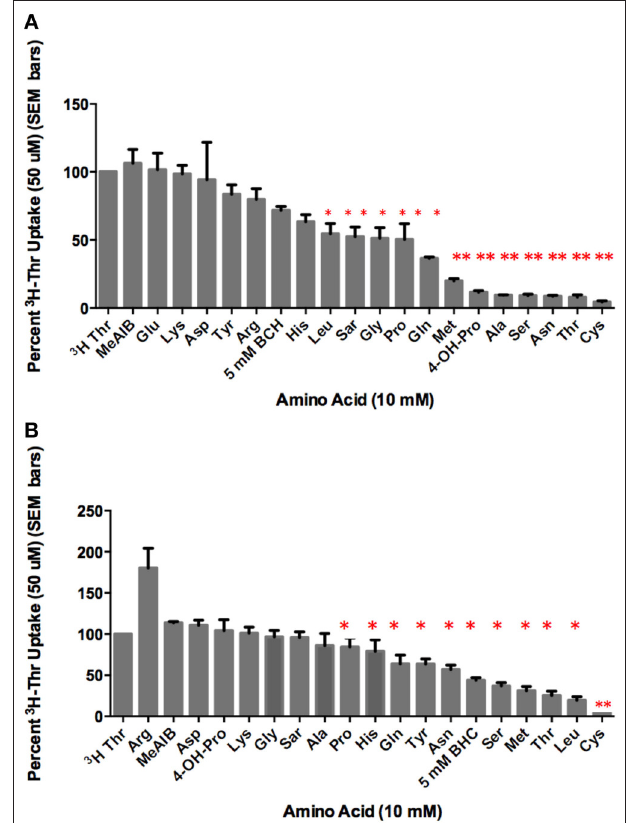
FIGURE 2 | Percent uptake of 50 uM [ 3 H]-Thr in the presence of 140mM NaCl and 10mM of the amino acid indicated. (A) A 1-sample t -test determined the more complete inhibitors (** p < 0.0001 ) and other statistically significant inhibitors ( * p < 0.05 ) ( n = 6 for each column; 3 determinations obtained in each of 2 independent experiments). (B) Percent uptake of 50 uM [ 3 H]-Thr in the presence of 280mM Mannitol and 10mM of the amino acid indicated. A 1-sample t -test determined the more complete inhibitor ( ** p < 0.0001 ) and other statistically significant inhibitors ( * p < 0.05 ) ( n = 6 for each column; 3 determinations obtained in each of 2 independent